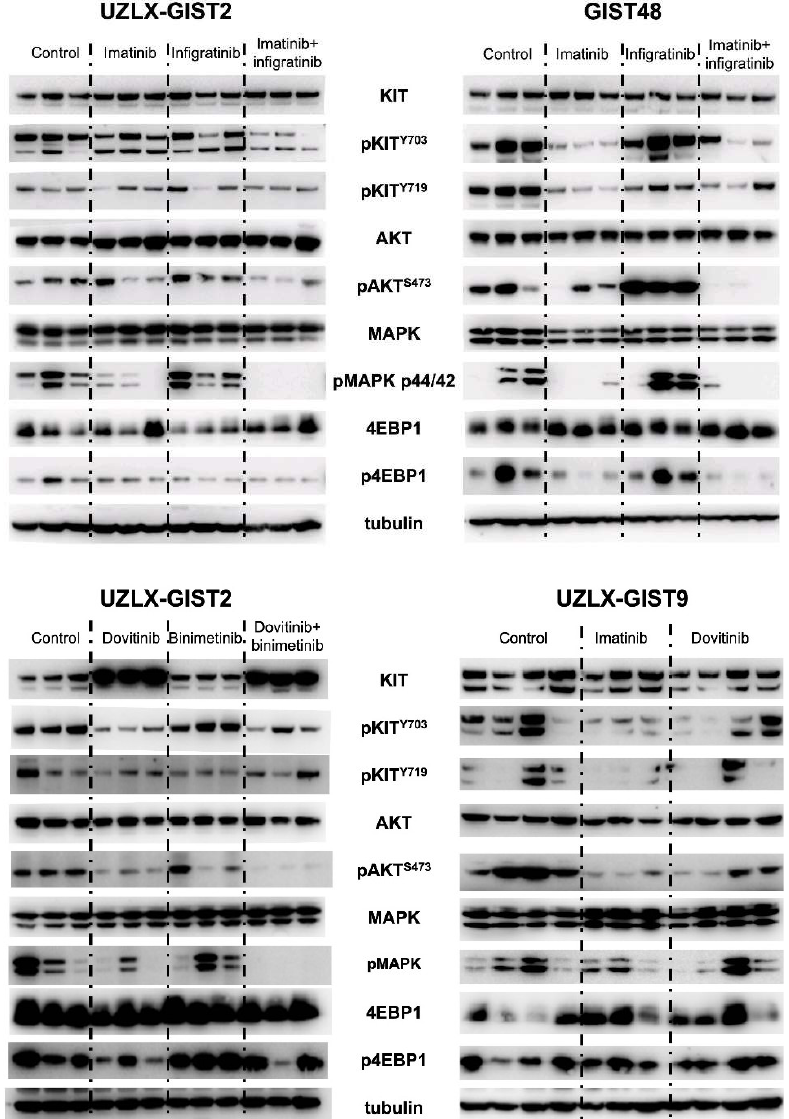
Figure 3. Western blotting results. Legend: Analysis of receptor tyrosine kinase signaling pathway for tumors collected after treatment, using three biological replicates per treatment group.